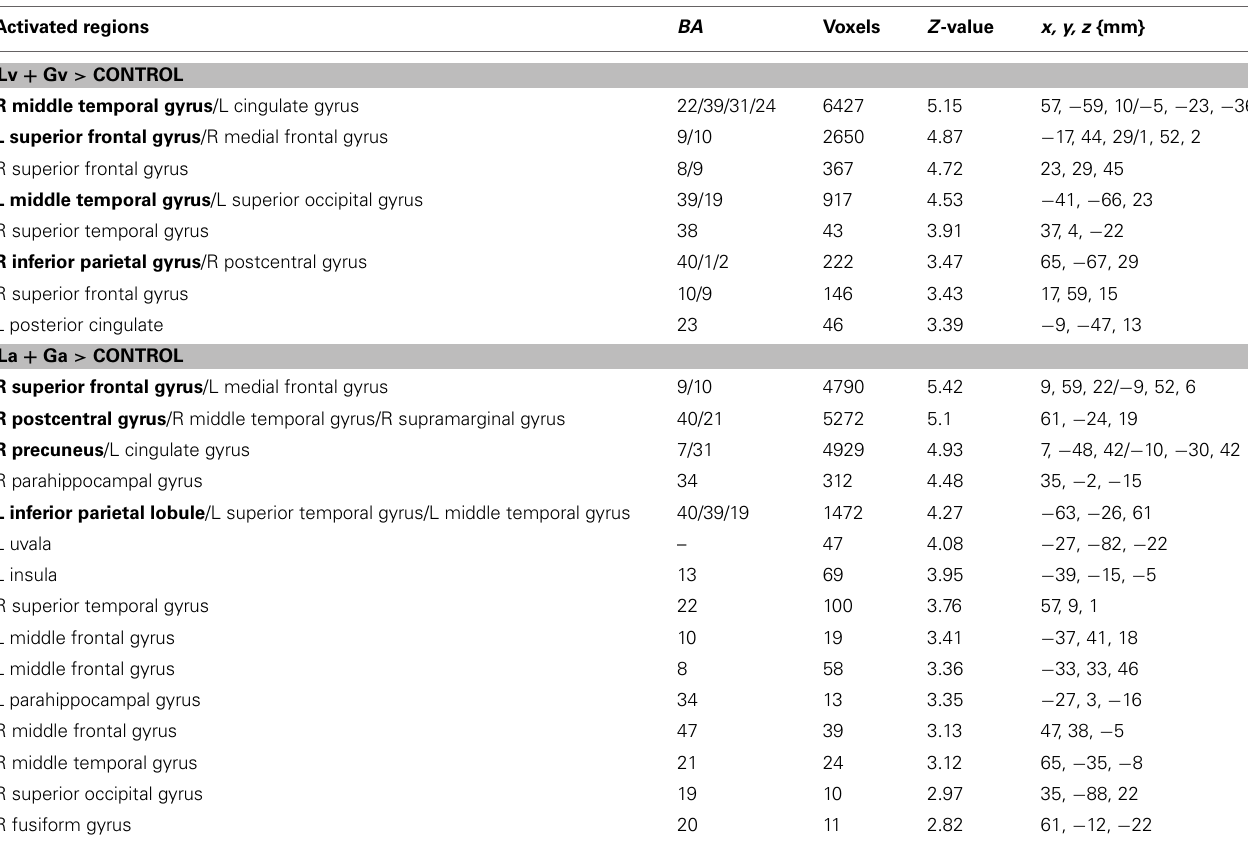
Table 1 | Brain regions showing significant activation for visual and auditory tasks compared to control tasks. Activated regions BA Voxels Z -value x, y, z {mm} Lv + Gv >